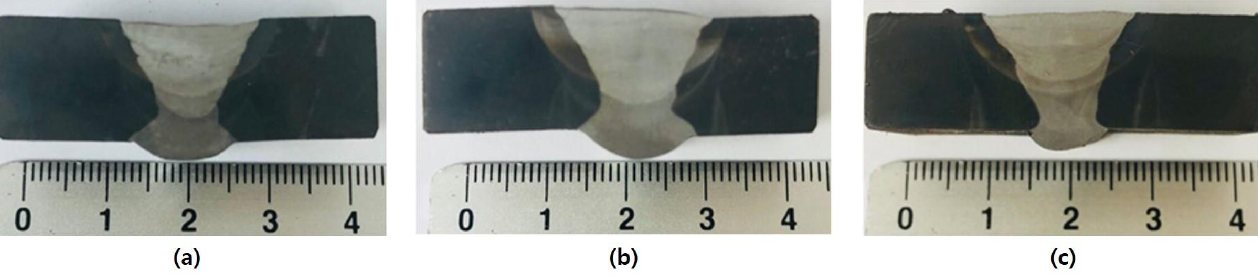
Figure 7. Sectional view analyses of FCAW weld with CO 2 5% and 20% shielding gas and heat input in butt joint: ( a ) 00L; ( b ) 00M; ( c ) 00H.